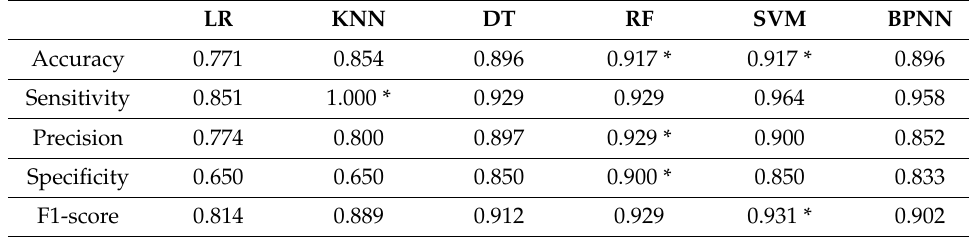
Table 2. Comparison of performance parameters of the six ML